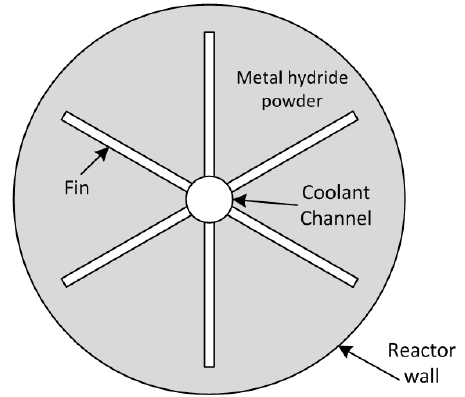
Figure 1. Cross ‐ sectional view of the six ‐ fin reactor model with the central cooling. Figure 1. Cross-sectional view of the six-fin reactor model with the central